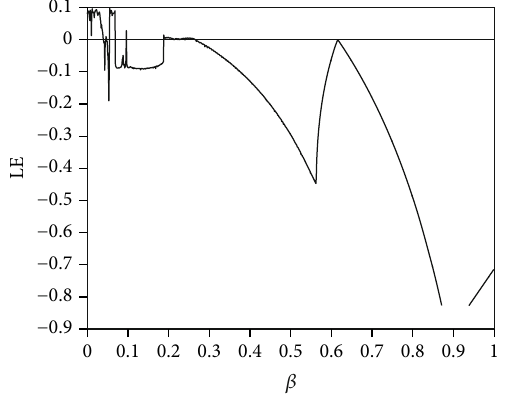
Figure 7: Bifurcation diagram with respect to α when β = 0 : 1, λ = 2 : 1,